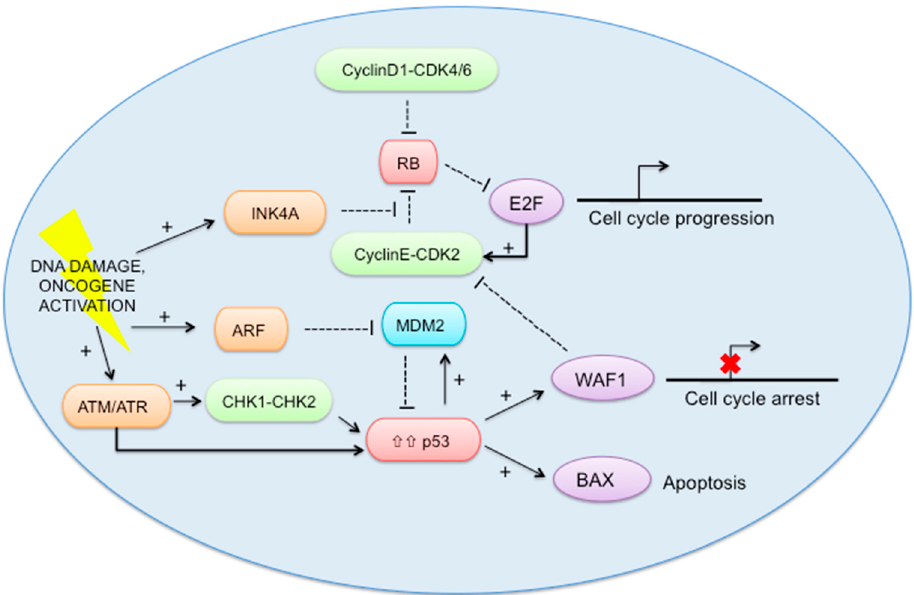
Figure 2. The RB-E2F and p53 pathways. INK4A: p16 protein, RB: retinoblastoma, E2F: E2 factor,